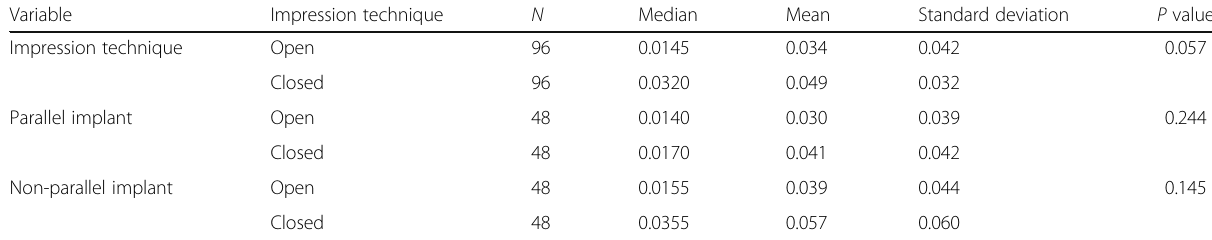
Table 1 Accuracy of implant impression technique in the horizontal direction Variable